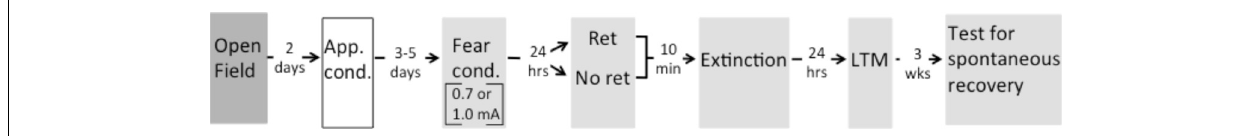
FIGURE 1 | Timeline of experimental design. Rats were first tested for their willingness to enter an illuminated open field. Rats then received appetitive conditioning (App. cond.) with 56 light-food pairings in Context A. On their last day of appetitive conditioning rats were classified as Orienters and Nonorienters. After 3–5 days, both groups were fear conditioned (Fear cond.) with 3 tone-shock pairings of either 0.7 or 1.0mA in Context B (indicated by gray shading). 24h after fear